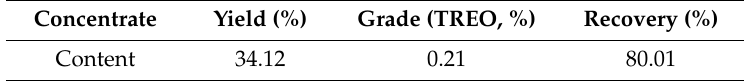
Table 5. The flotation result of total rare ‐ earth oxide (TREO) under the optimal flotation conditions by ICP analysis.